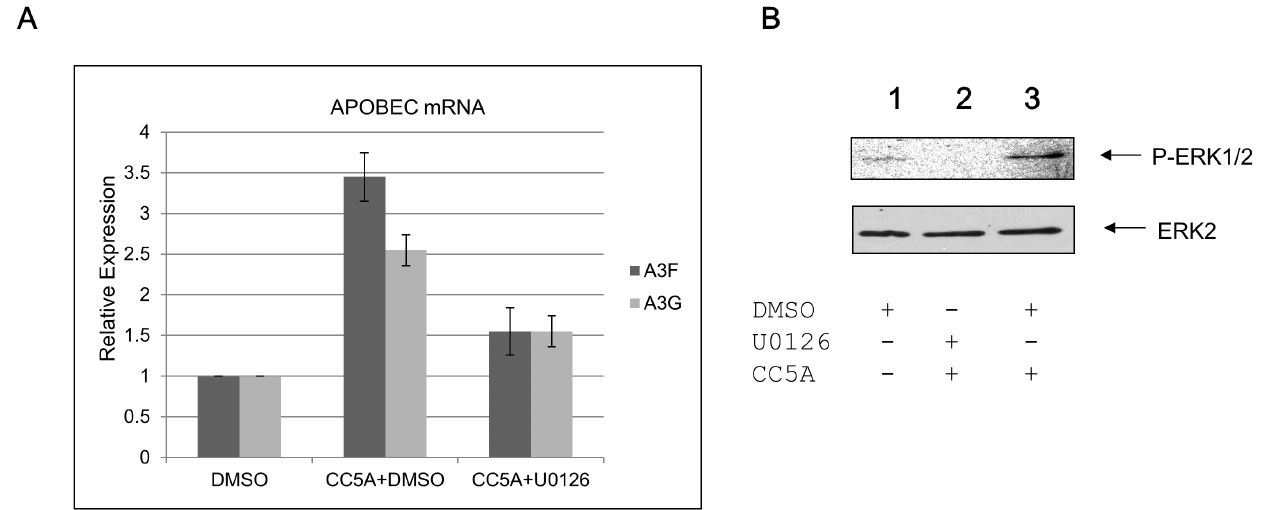
Figure 3. A3F and A3G are regulated through the MEK1/2 dependent pathway. ( A ) Prior to treatment with CC5A/PBS for 16 h, THP-1 cells were pre-treated by DMSO alone or the ERK1/2 inhibitor U0126 in DMSO for 1 h. The induction of A3G and A3F was measured by qRT-PCR. (B) Lysates from THP-1 cells pre-treated DMSO or U0126 in DMSO, following by CC5A/PBS (40 m g) are subjected to Western blot analysis. Phosphorylated ERK1/2 and ERK1/2 were probed by anti-p-ERK1/2 and anti-ERK2,